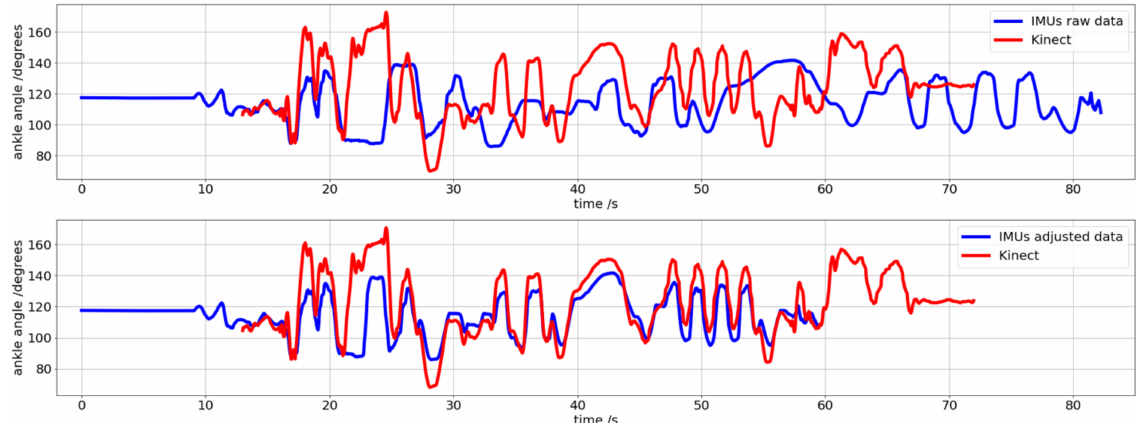
Figure 7. Real synchronization example for the IMUs and the Kinect before ( up ) and after ( bottom ) their adjustment.